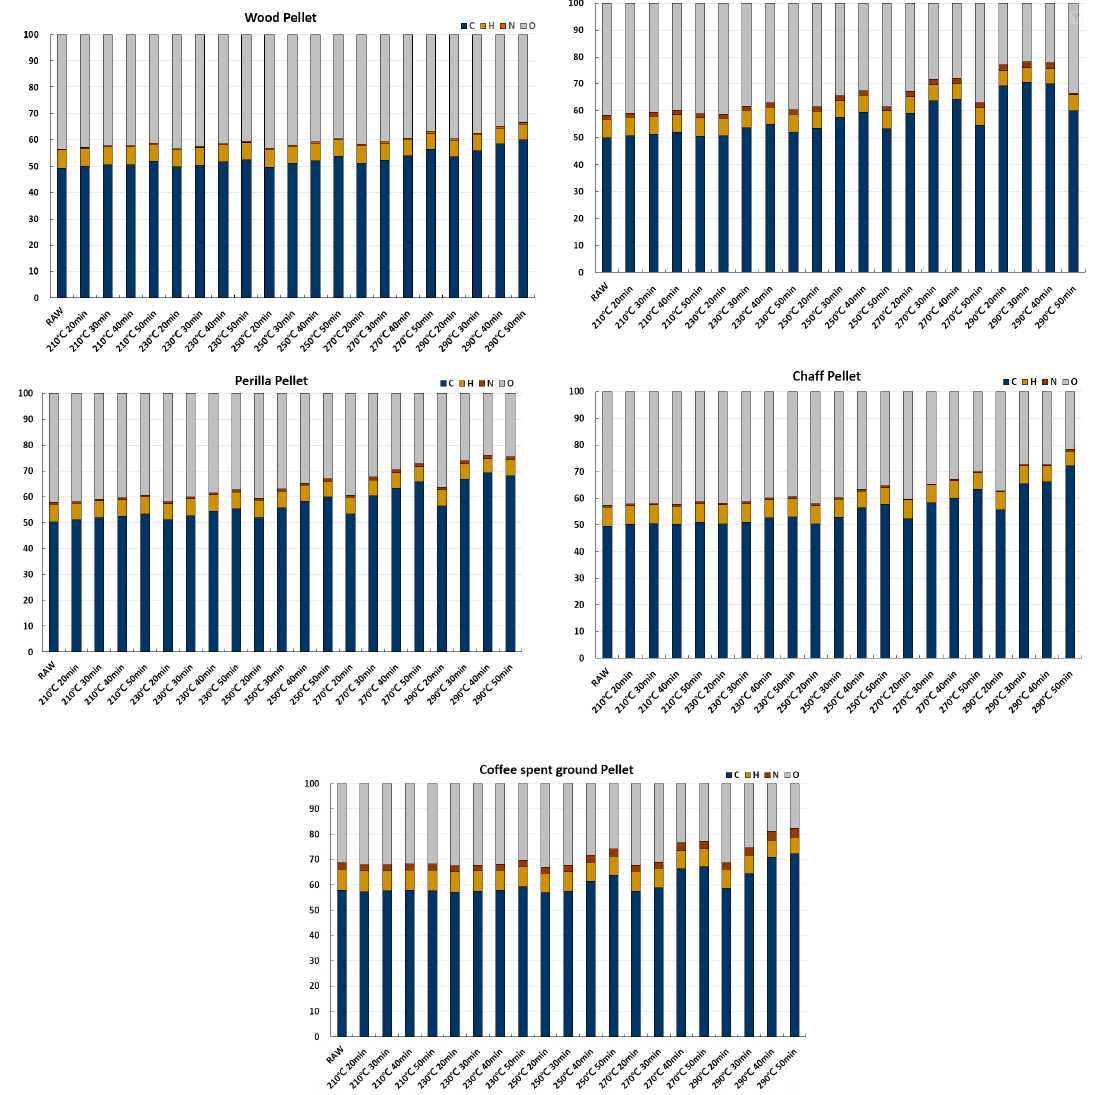
Figure 2. Element component ratio of each torrefied pellet.